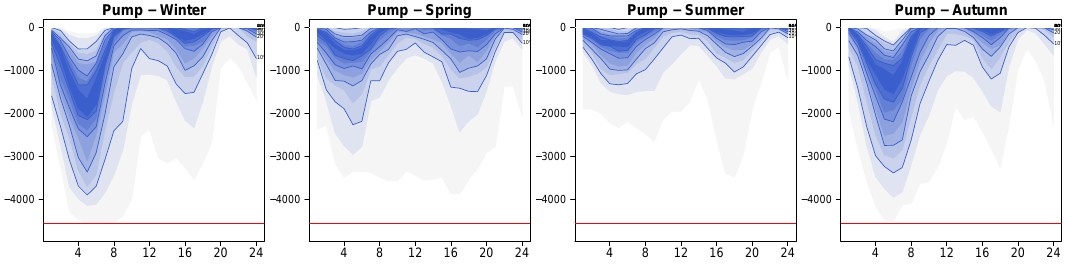
Figure 10. The hourly pump storage consumption pattern for each season. Units: vertical axis, MW; horizontal axis, hour. Source: authors based on the hourly data from REE